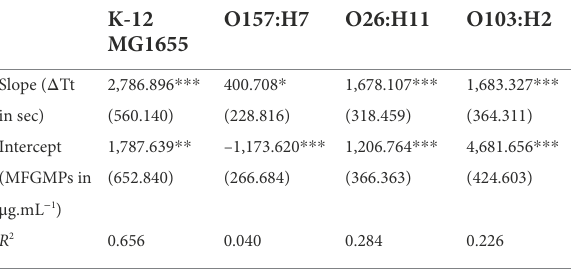
For each serotype (O157:H7, O26:H11, O103:H2) and the K-12 MG1655 strain, a simple linear regression was used to assess the relationship between the time threshold for bacterial growth ( Δ Tt) and the amount of MFGMPs. Standard errors are indicated in